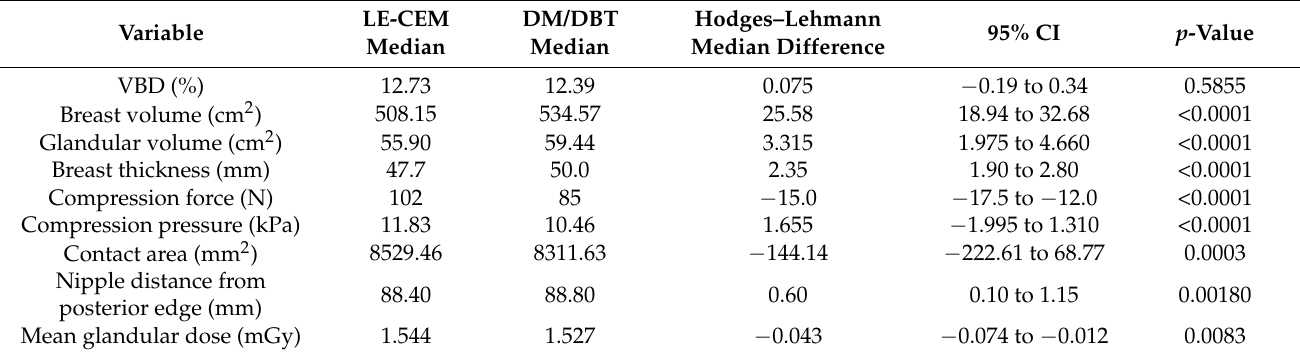
Table 2. Comparison between CEM and DM/DBT of volumetric breast density and related